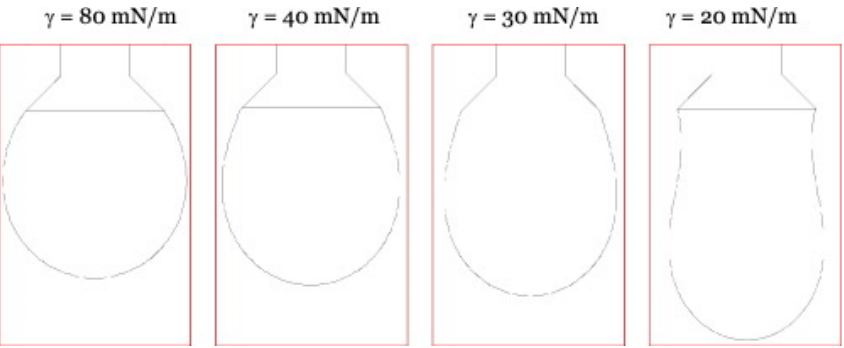
Figure 8. Axisymmetric drop shape analysis. Pendant drop shapes with different surface tensions using a 10 µL drop. Source: [87].